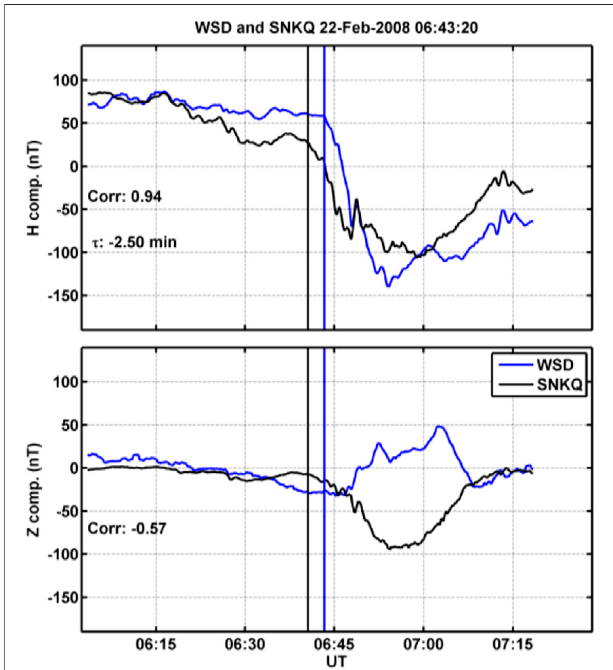
FIGURE 1 | Example of onsets that simultaneously occur in both WSD (blue curve) in the southern hemisphere and the SNKQ (black curve) in the northernhemisphere.Inthetoppanelisthe H componentofthemagnetic fi eld data and cross correlation coef fi cient and the onset time difference determinedfromcrosscovariance.Thesouthernhemisphereonsetismarked with the blue vertical line, and the northern hemisphere onset is marked with the black vertical line. In the bottom panel is the Z components and the cross correlation value.